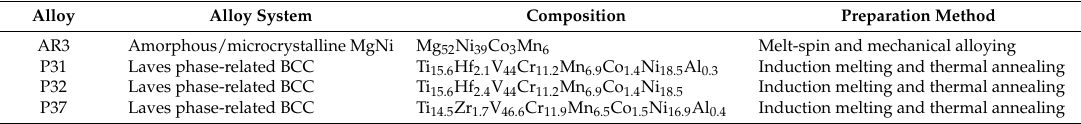
Table 1. Compositions of the four metal hydride (MH) alloys used in this study. BCC: body-centered